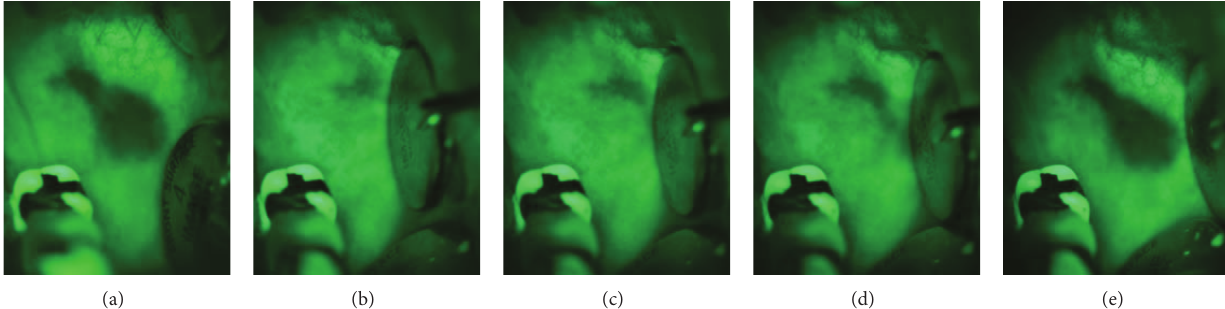
Figure 1: Oral lichen planus on left buccal mucosa displaying loss of autofluorescence when visualised using VELscope (a). The same lesion displaying diascopic fluorescence on application of pressure (b)–(d), returning to its original appearance when pressure is removed